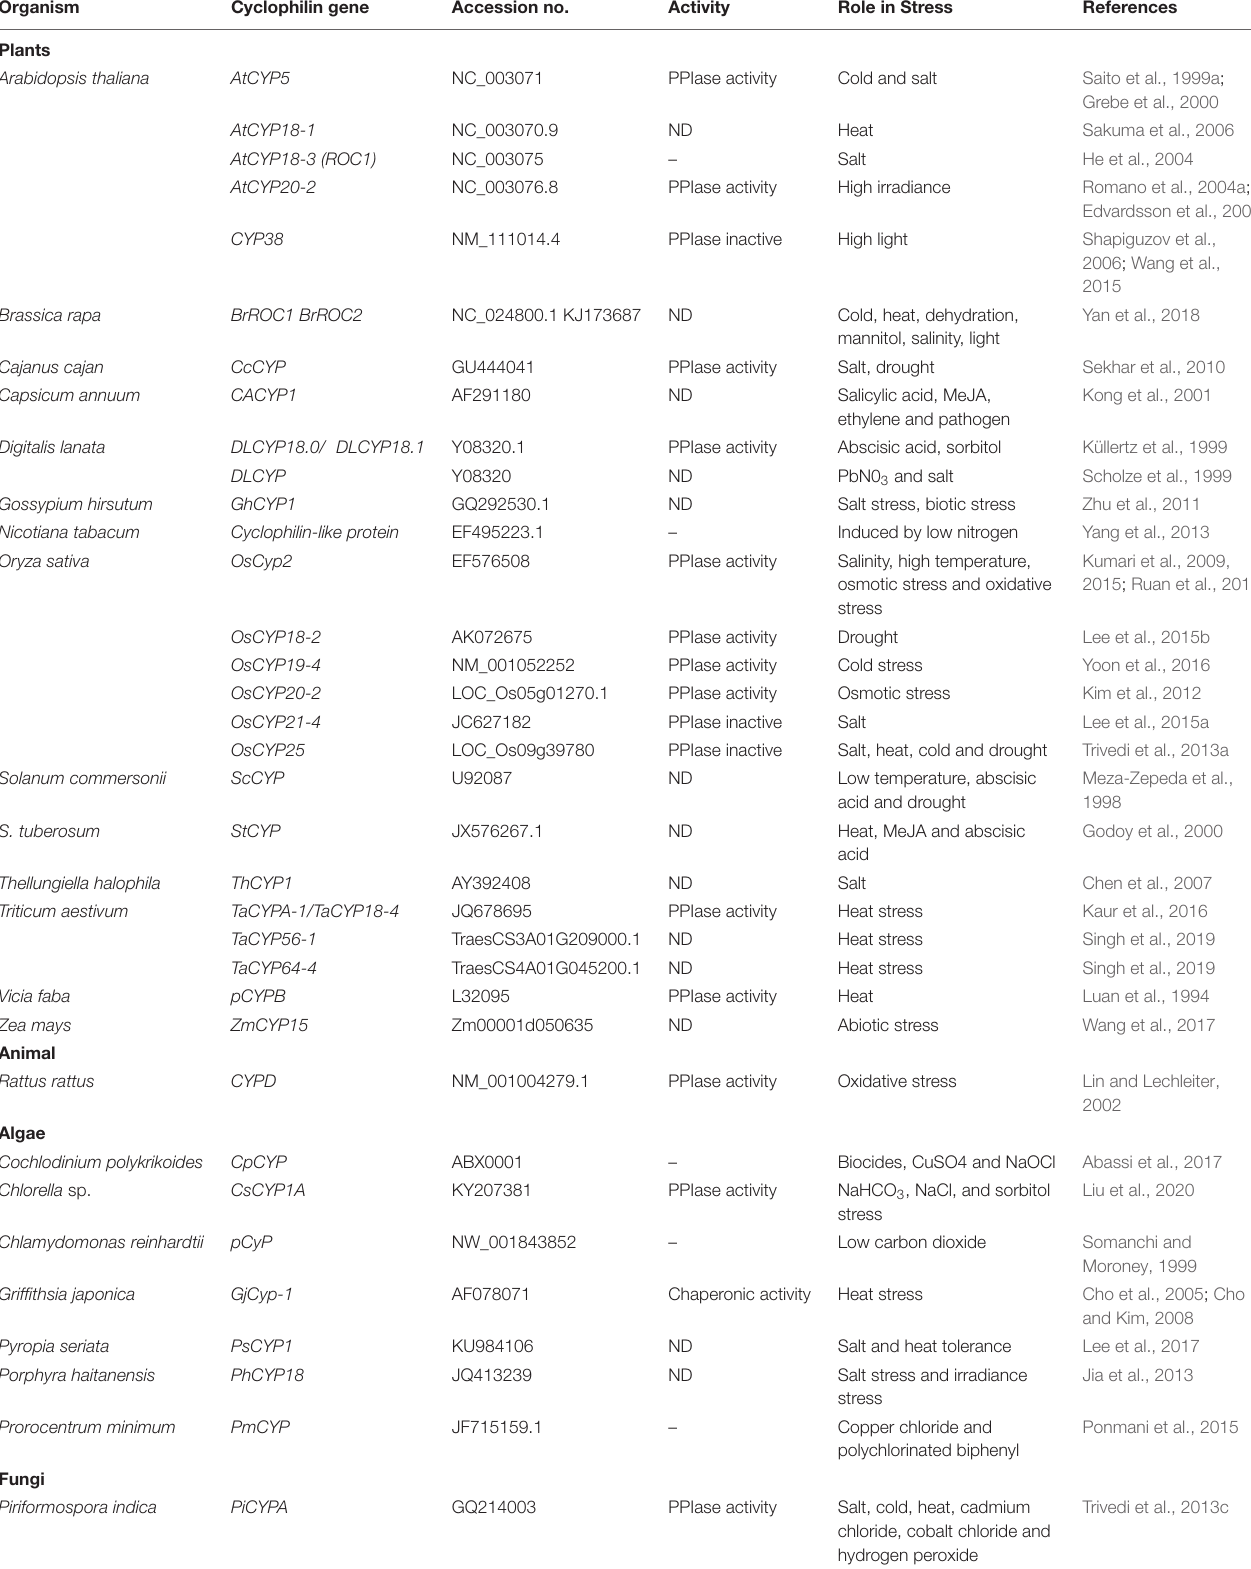
TABLE 7 | Abiotic stress modulated cyclophilin